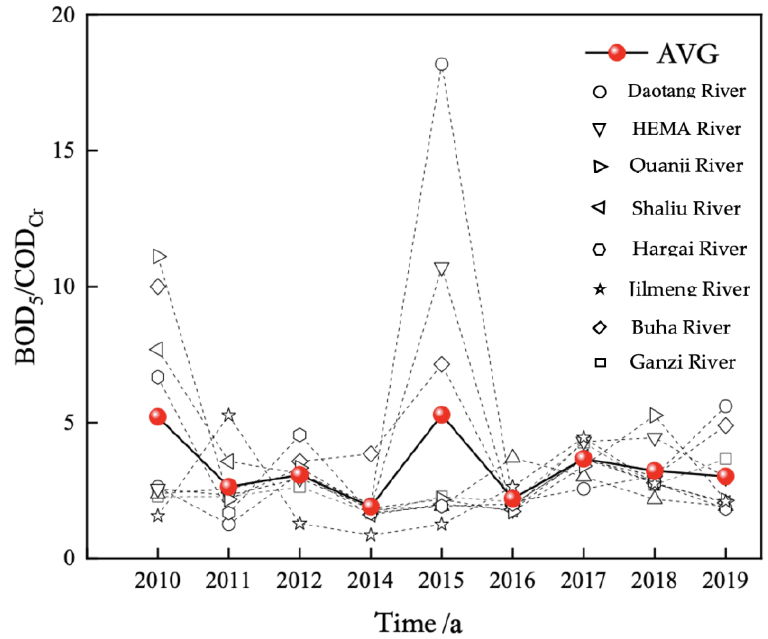
Figure 19. Bioavailability of DOM in Qinghai Lake.